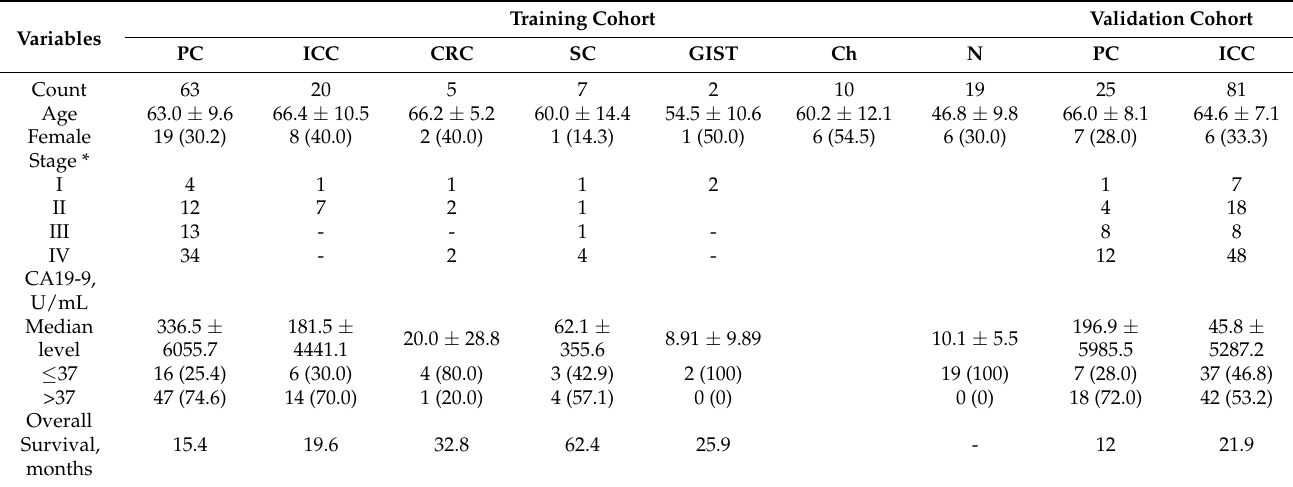
Table 1. Clinical characteristic of the samples used for the identification and validation of the diagnostic markers.